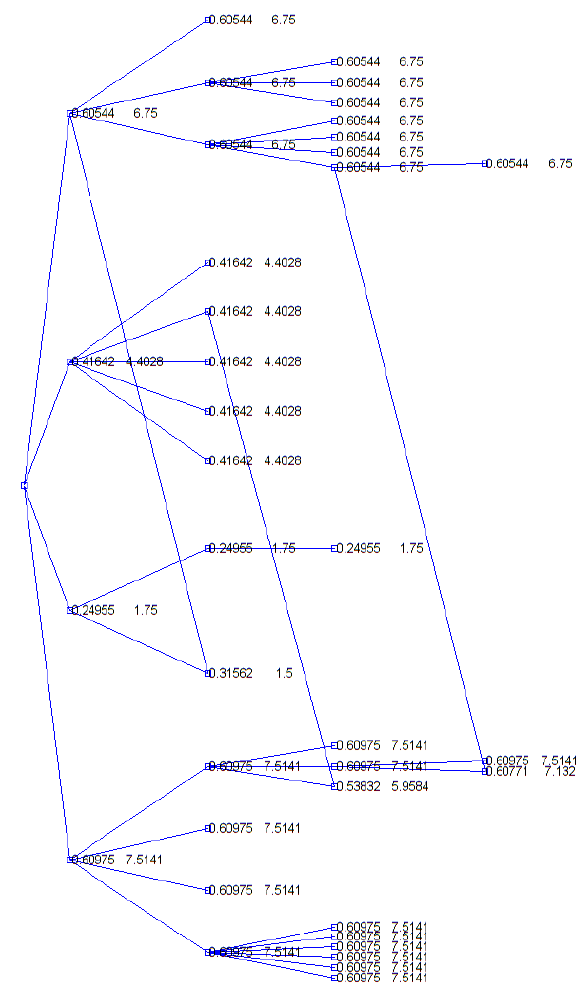
Figure 6. Updated user profile in second method.